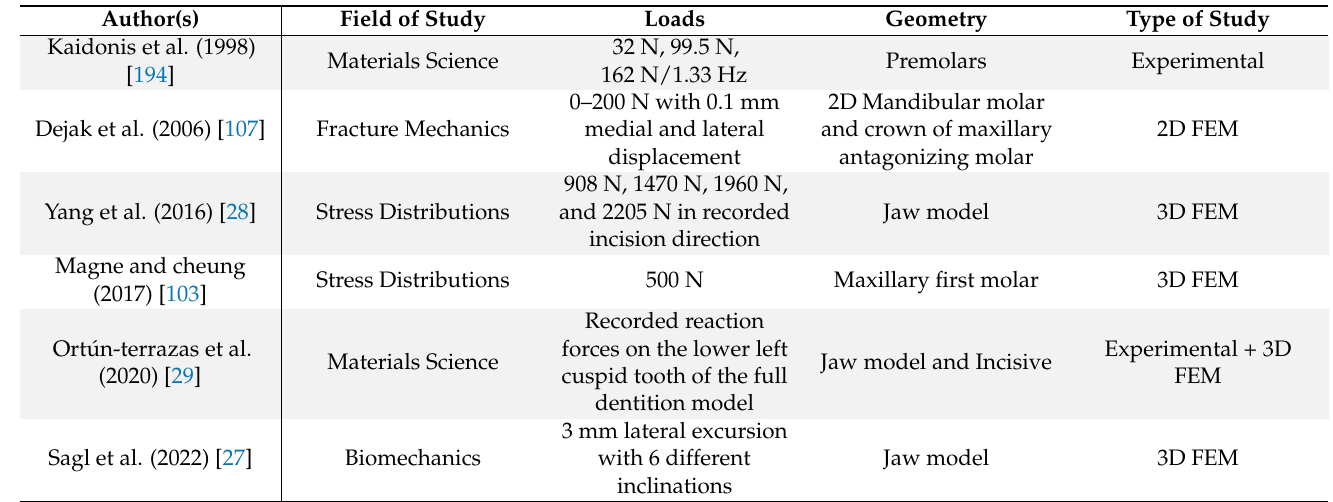
Table 8. Summary of experimental and FEM studies on grinding